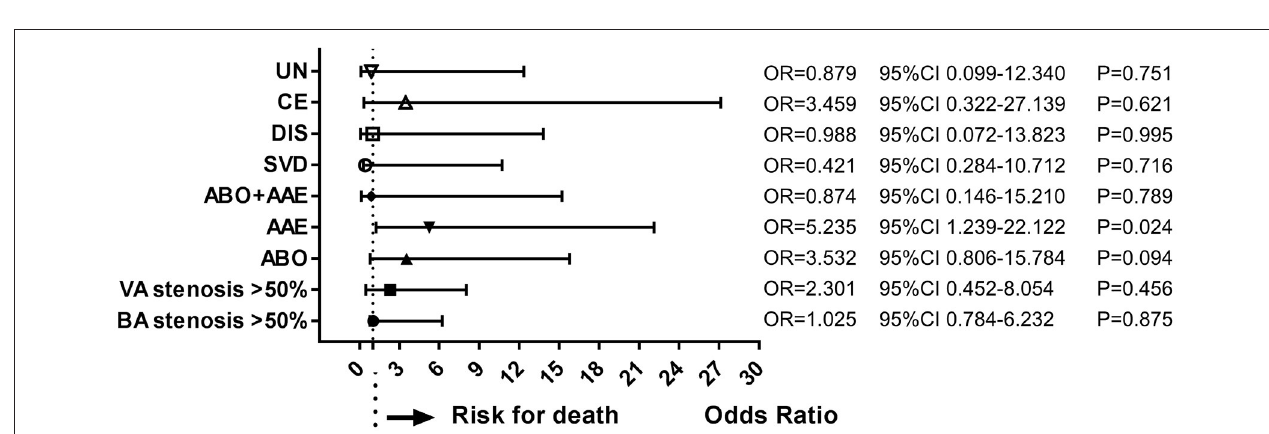
FIGURE 4 | Clincal risk factors for death. Age ≥ 65 years, dysphagia, and stroke recurrence were risk factors for death.